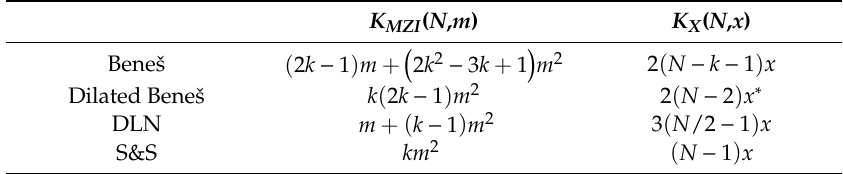
Table 3. Topology comparison in terms of cumulative crosstalk generated by MZIs and waveguide crossings for each